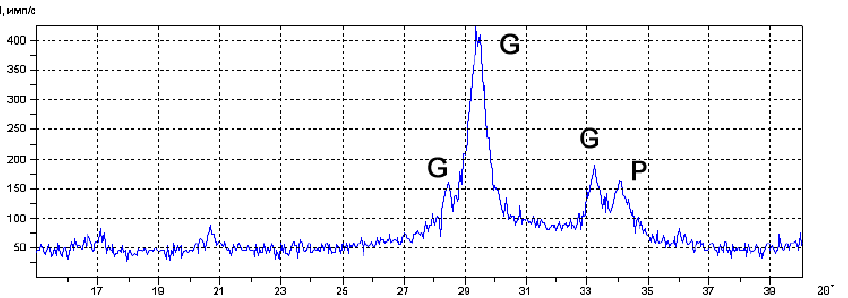
Figure 4. XRD pattern of YAG aerosol powders, made of a solution containing yttrium nitrate hexahydrate. Phase marking: G–YAG (Y 3 Al 5 O 12 ); P–YAP (YAlO 3 ).